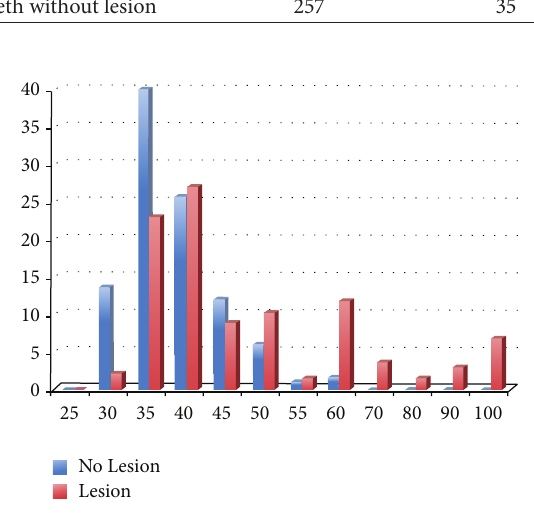
Figure 1: Data comparison of the 2